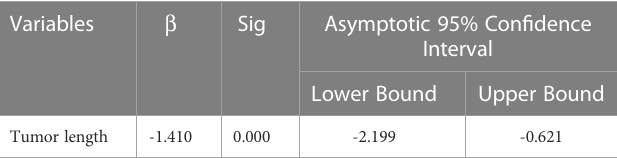
TABLE 8 The effect of tumor length on hemoglobin.